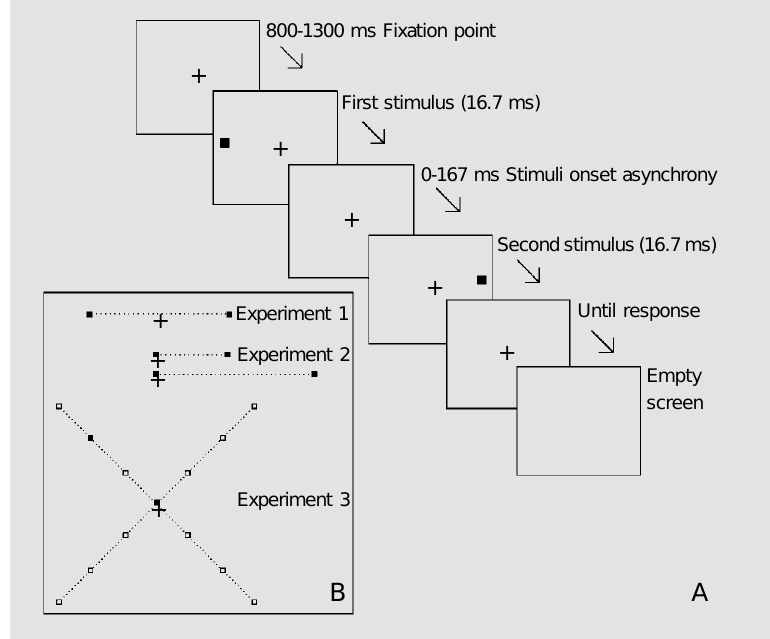
Figure 1. A , Temporal sequence of events used in all three experiments. B , Schematic representation of stimulus display. In Experiment 1 , the eccentricity of both stimuli was 4.8 º from the fixation point (the cross in the center of the display). In Experiment 2 , the peripheral stimulus was presented in blocked trials in one of two eccentricities (4.8 º and 9.6 º ). Experiment 3 involved three conditions: 1) the peripheral stimulus was presented in the temporal superior visual quadrant, in separate blocks in three different eccentricities (2.5 º , 7.3 º and 12.1 º ), 2) the peripheral stimulus was randomly presented in the temporal superior visual quadrant, in the same three different eccentricities, and 3) the peripheral stimulus was presented randomly in twelve positions, a combination of the same three eccentricities and four visual quadrants (open